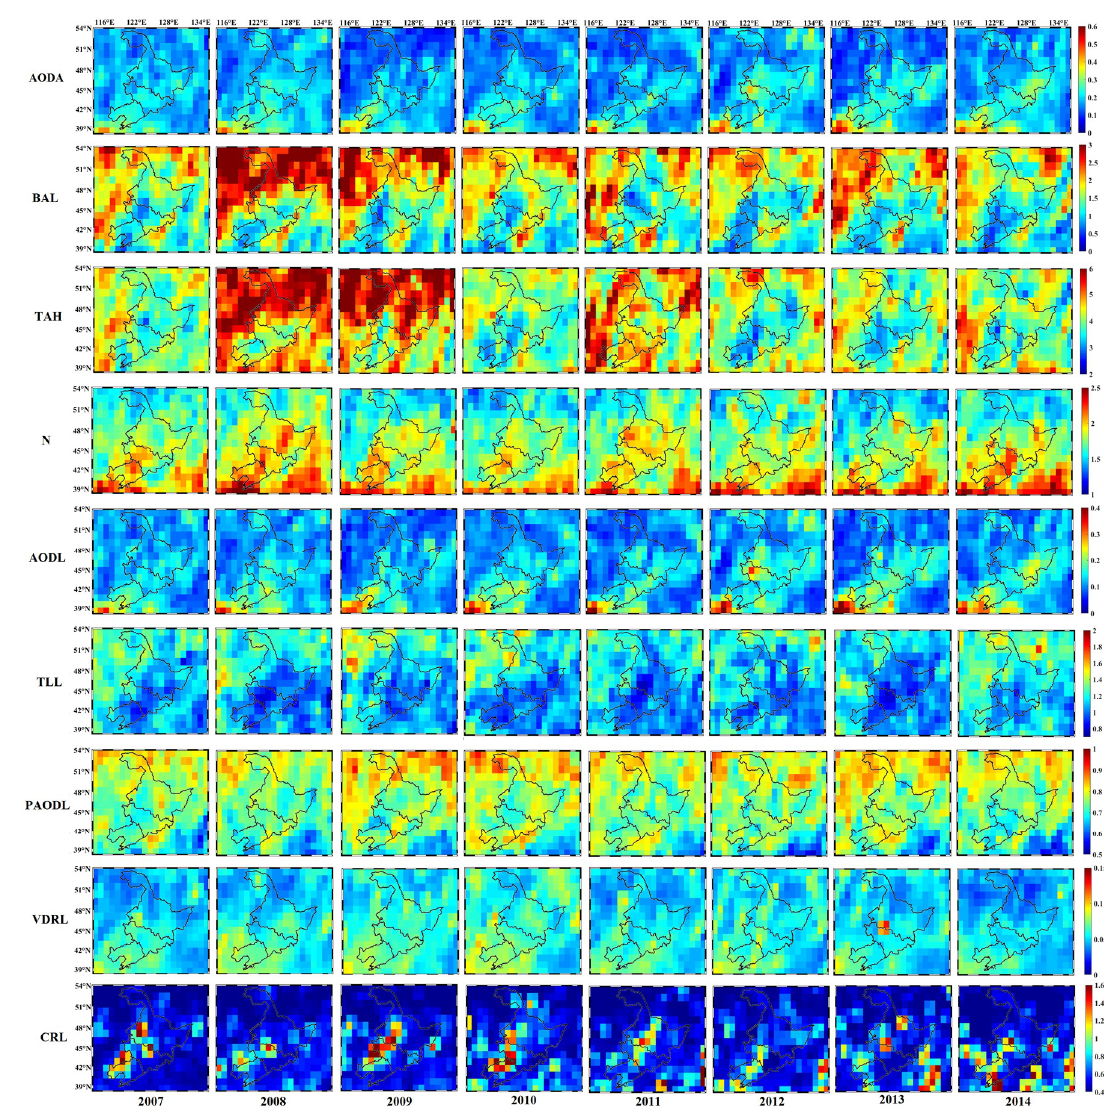
Figure 5. Inter‐annual spatial distributions of AODA, BAL, TAH, N, AODL, TLL, PAODL, VDRL, Figure 5. Inter-annual spatial distributions of AODA, BAL, TAH, N, AODL, TLL, PAODL, VDRL, and and CRL over NEC (HLJ, JL, and LN) in the nighttime, from 2007 to 2014. CRL over NEC (HLJ, JL, and LN) in the nighttime, from 2007 to